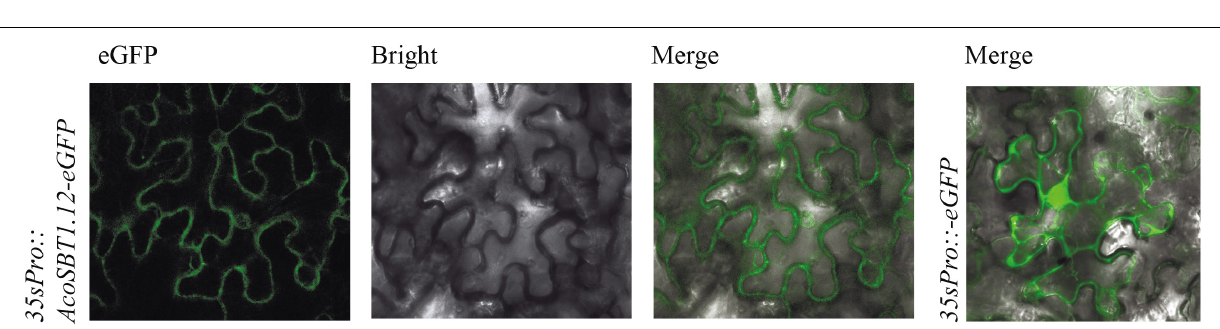
FIGURE 7 | Subcellular location of AcoSBT1.12. The subcellular location of AcoSBT1.12 and blank vector were detected on the surface cells of Nicotiana Benthamiana’ s